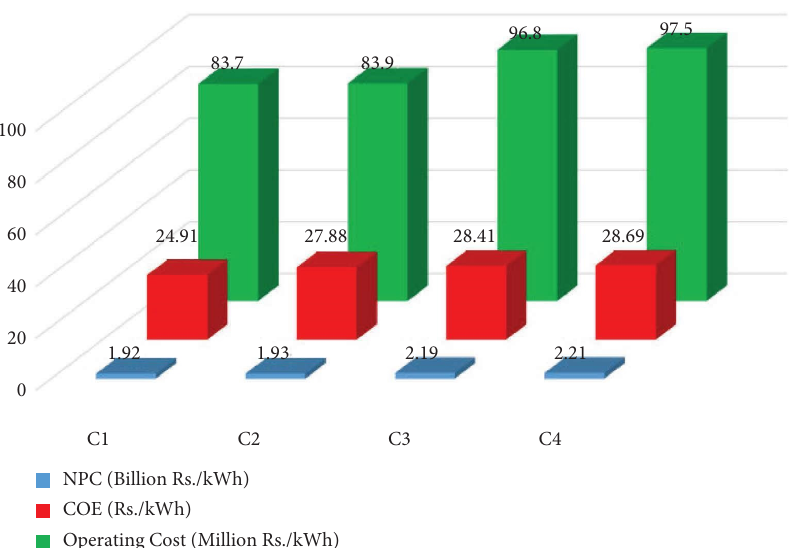
Figure 12: Comparison of diferent HRESs with operating cost, NPC, and COE.